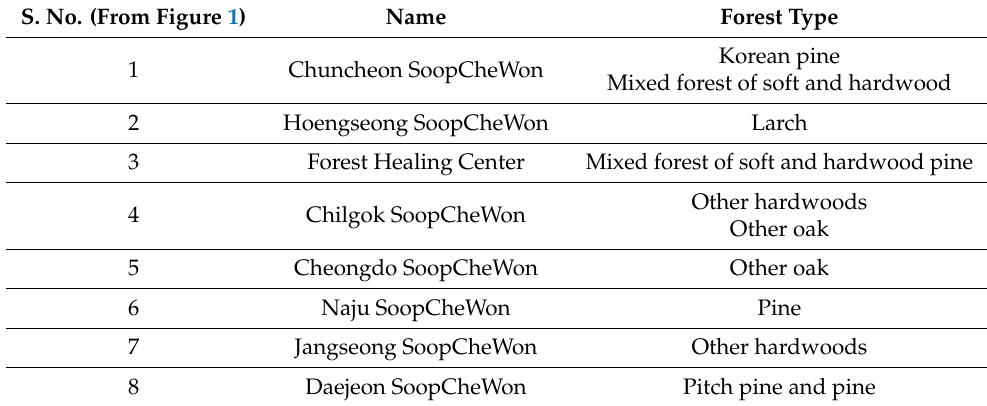
Table 2. Study site location and